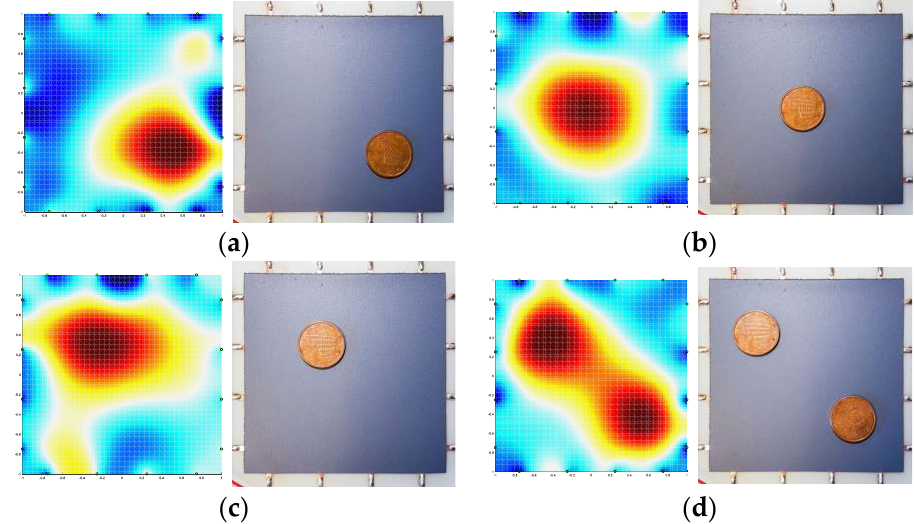
Figure 16. ERT object localization tests: ( a – c ) single coin in different positions; ( d ) two coins on the surface.